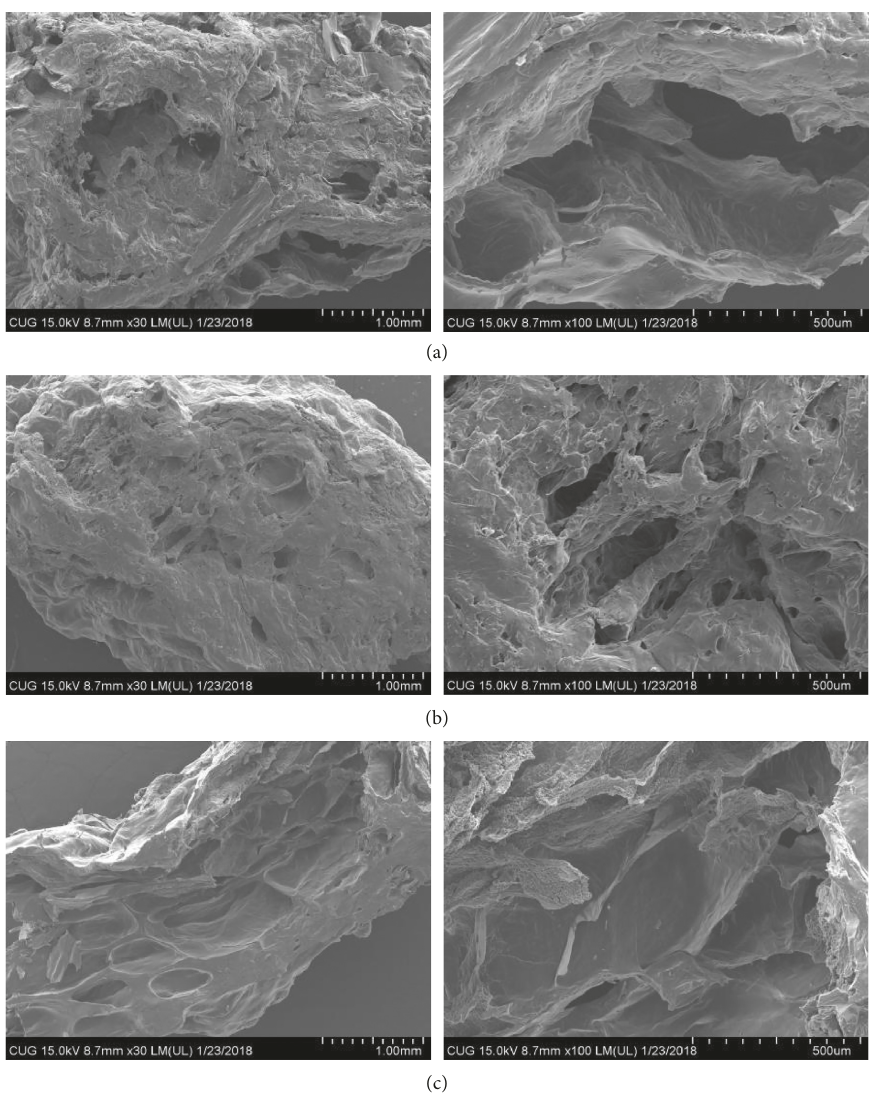
Figure 5: Scanning electron micrographs of kiwifruit samples dried by FVD (a), AD (b), FVD-AD (c). FVD, freeze vacuum drying; AD, air drying; FVD-AD, combined drying consisting of freeze vacuum drying and air drying.